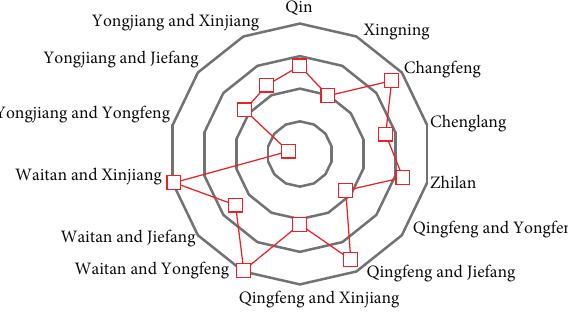
Figure 5: Delays from driving around the detoured Table 4: Traffic information on Jiangxia and Ling Bridges under three different scenarios.